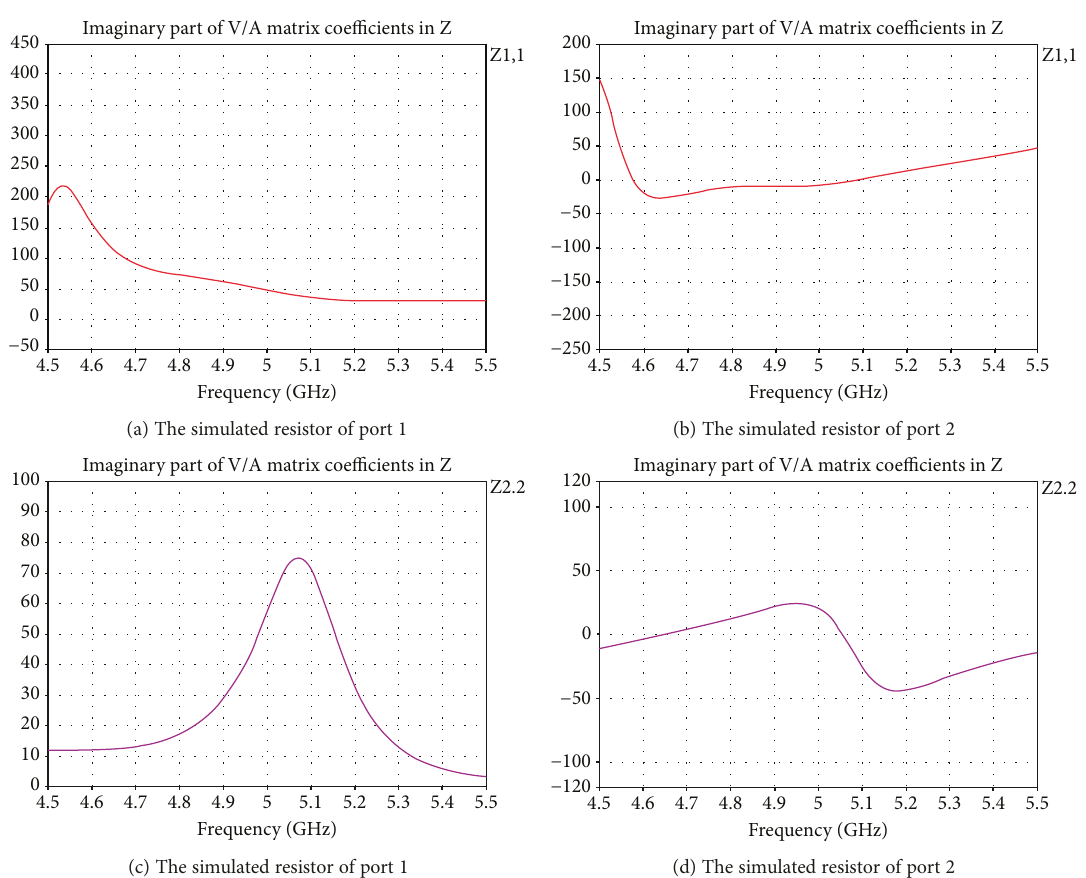
Figure 4: The simulated input impedance characteristics of two